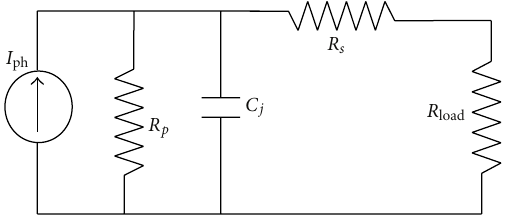
Figure 5: Equivalent circuit for small-signal analysis.